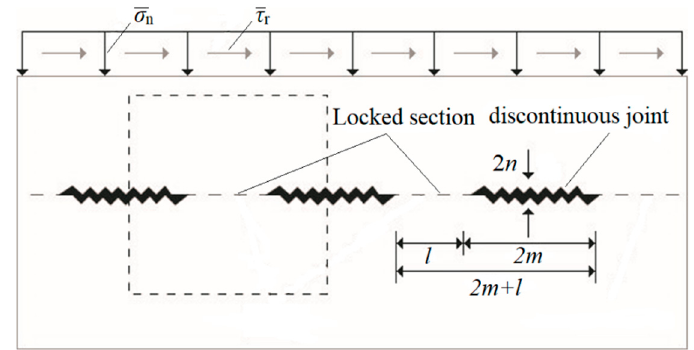
Figure 10. Speed curve of slope instability process.